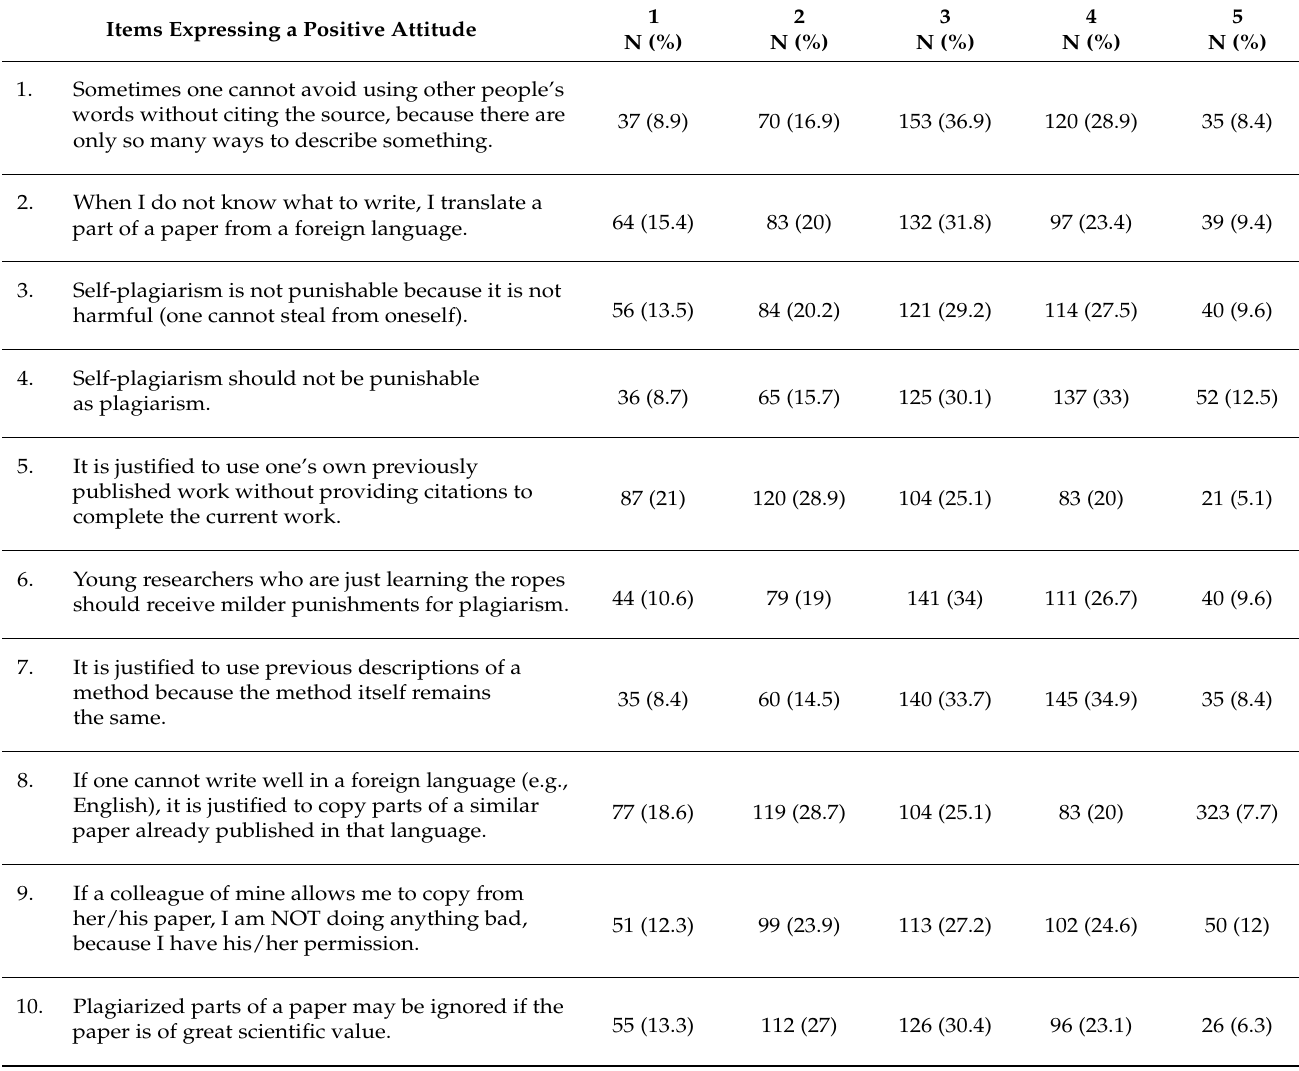
Table 3. Distributions of responses to the positive attitude plagiarism questionnaire (N =